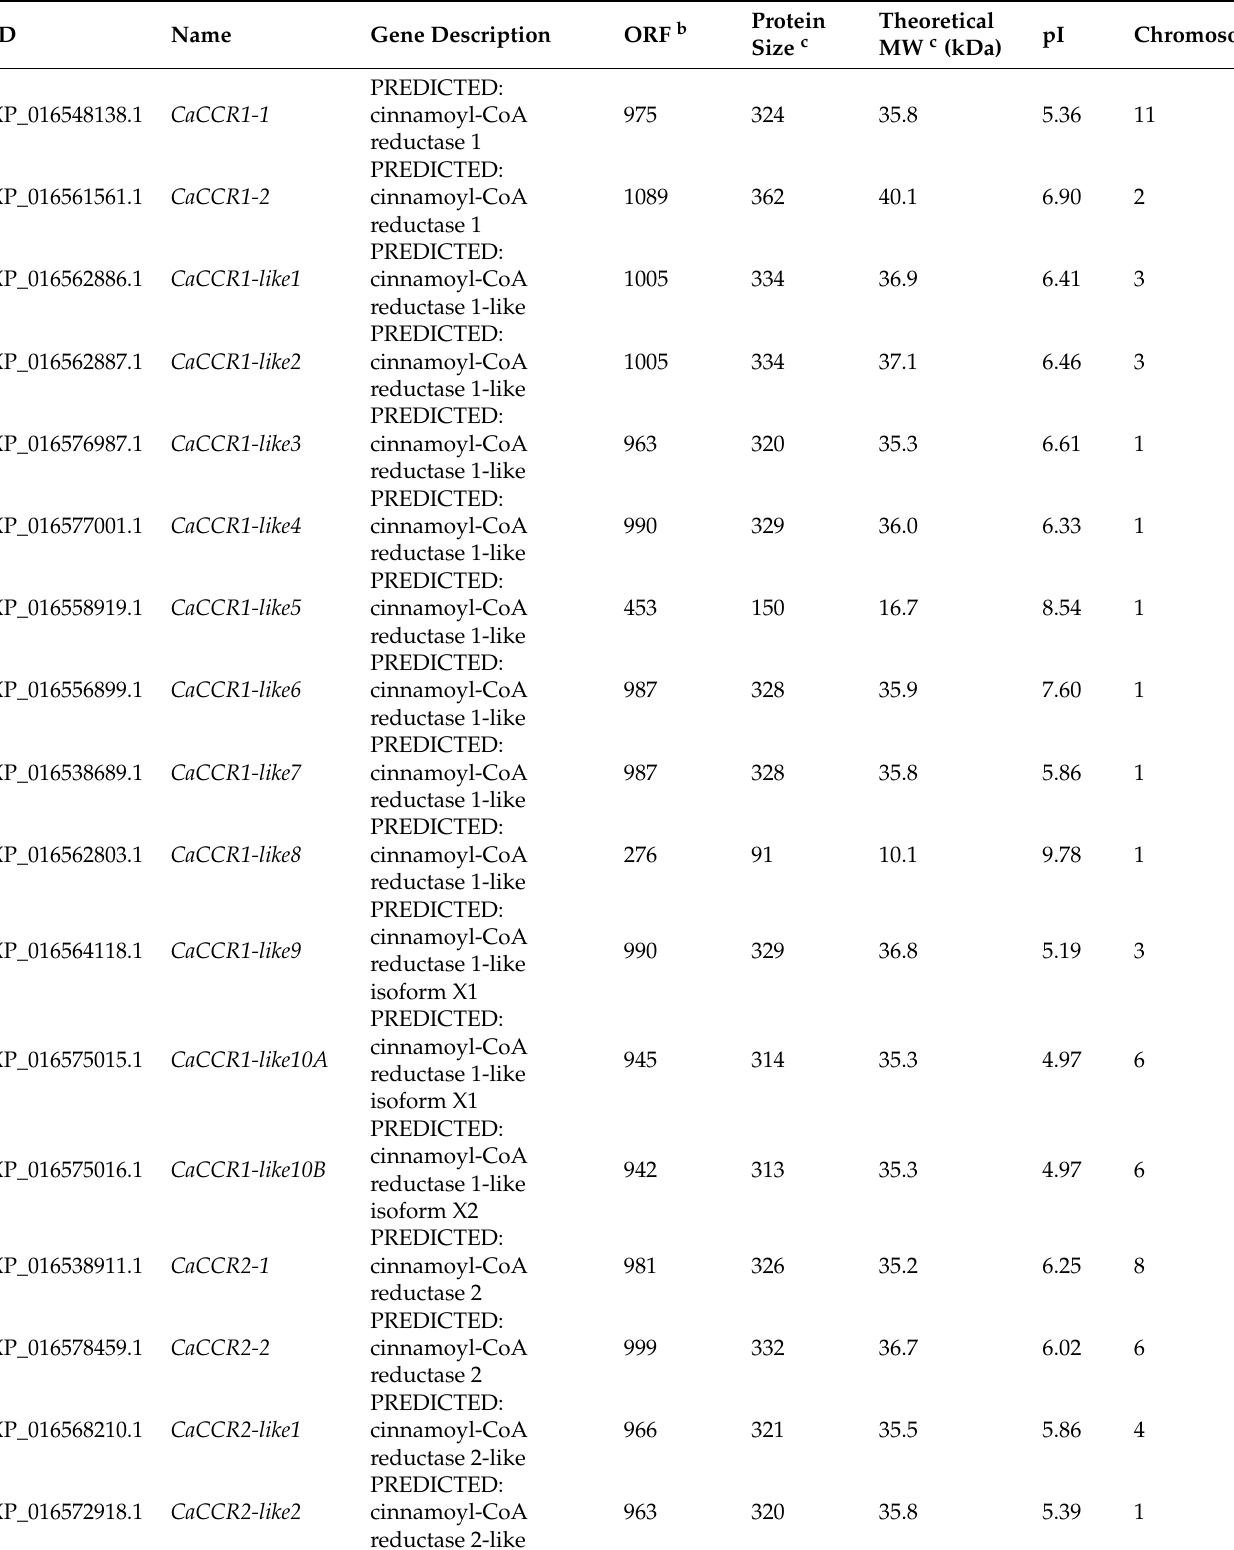
Table 1. Pepper CCR and CCR-like gene family. a a pepper genes annotated as CCRs and CCR-like (CCR/DFR/epimerase 3 β -HSD) proteins were retrieved from the MSU RGAP database. b ORF, open reading frame; c MW, molecular